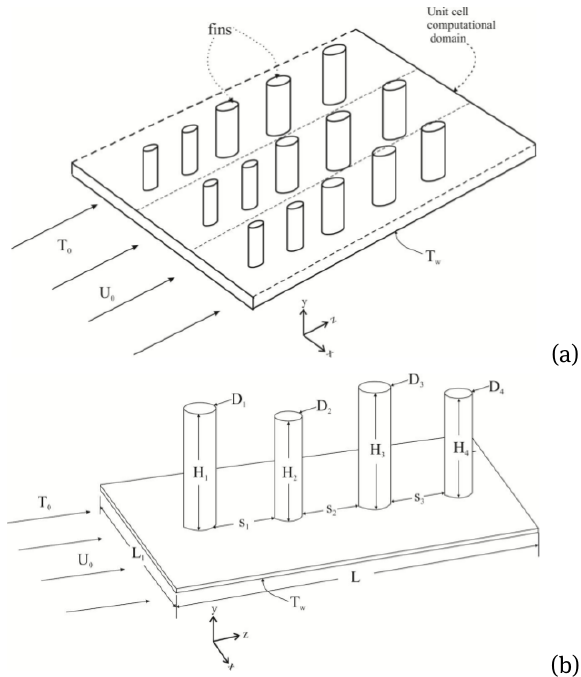
Figure 1: (a) Physical model of micro finned heat sink. (b) Computa- tional model of micro finned heat